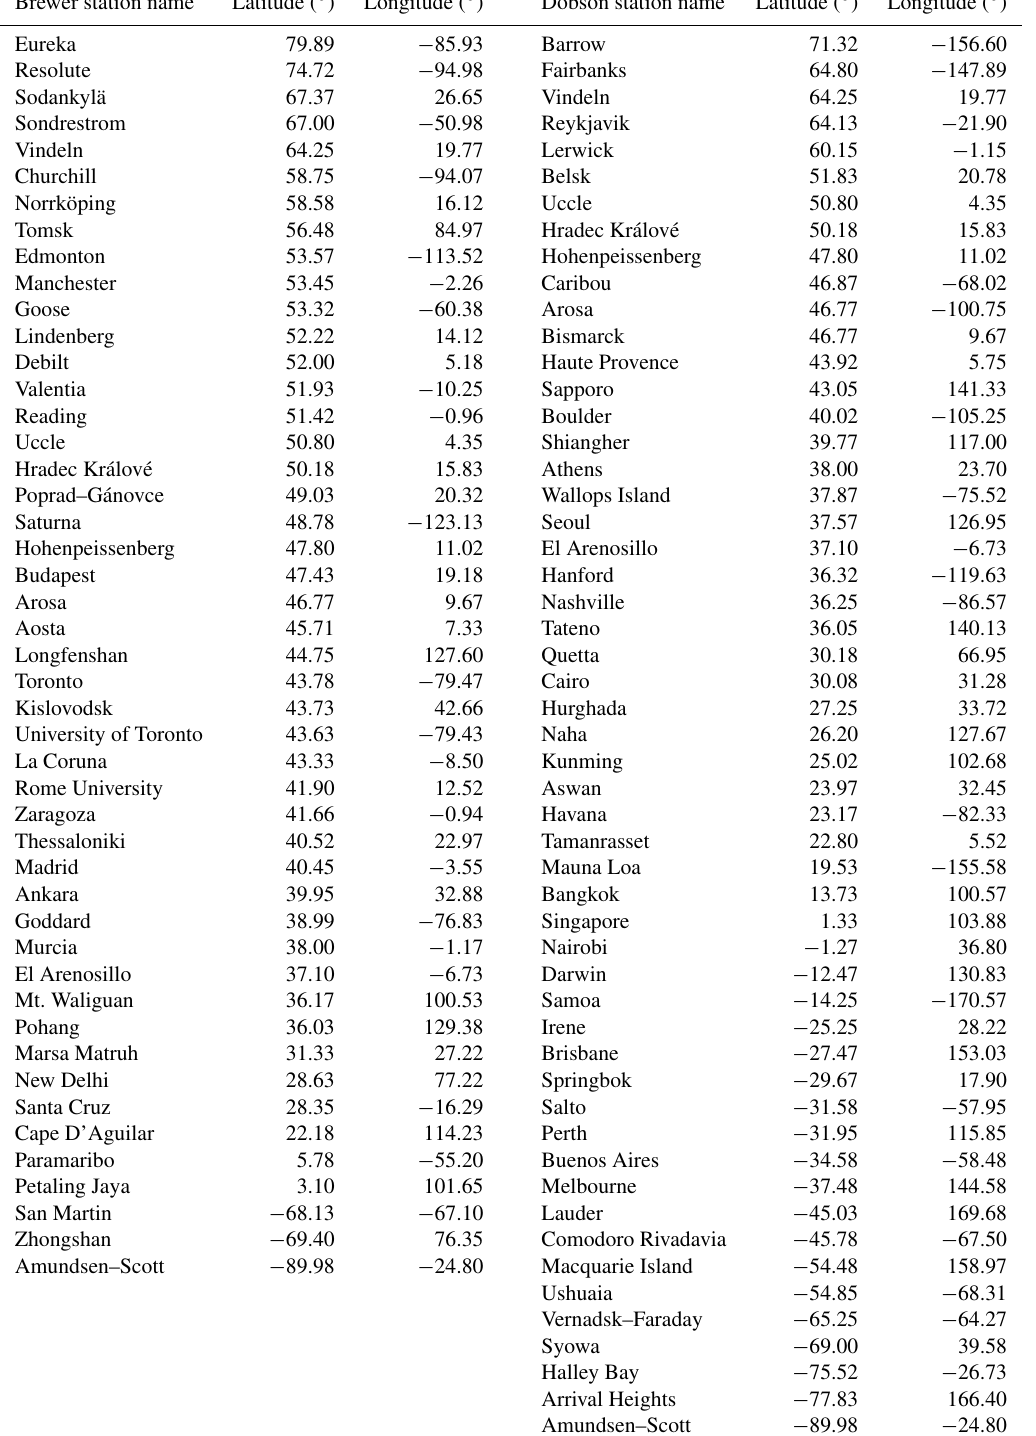
Table A1. List of the 47 Brewer and 53 Dobson quality-assured stations that contribute to the entire validation time period from 2008 to 2014